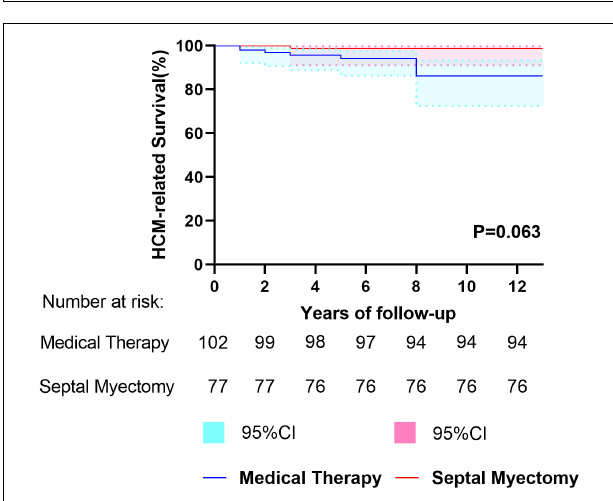
FIGURE 2 | Kaplan–Meier curves depicting HCM-related survival between the septal myectomy and medical therapy groups.